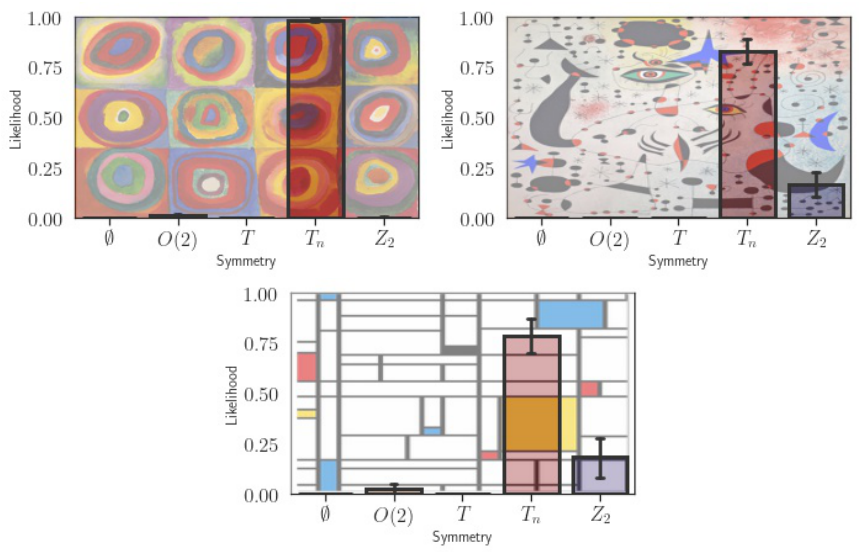
Figure 5: Examples of discrete translation symmetry across artists and schools.